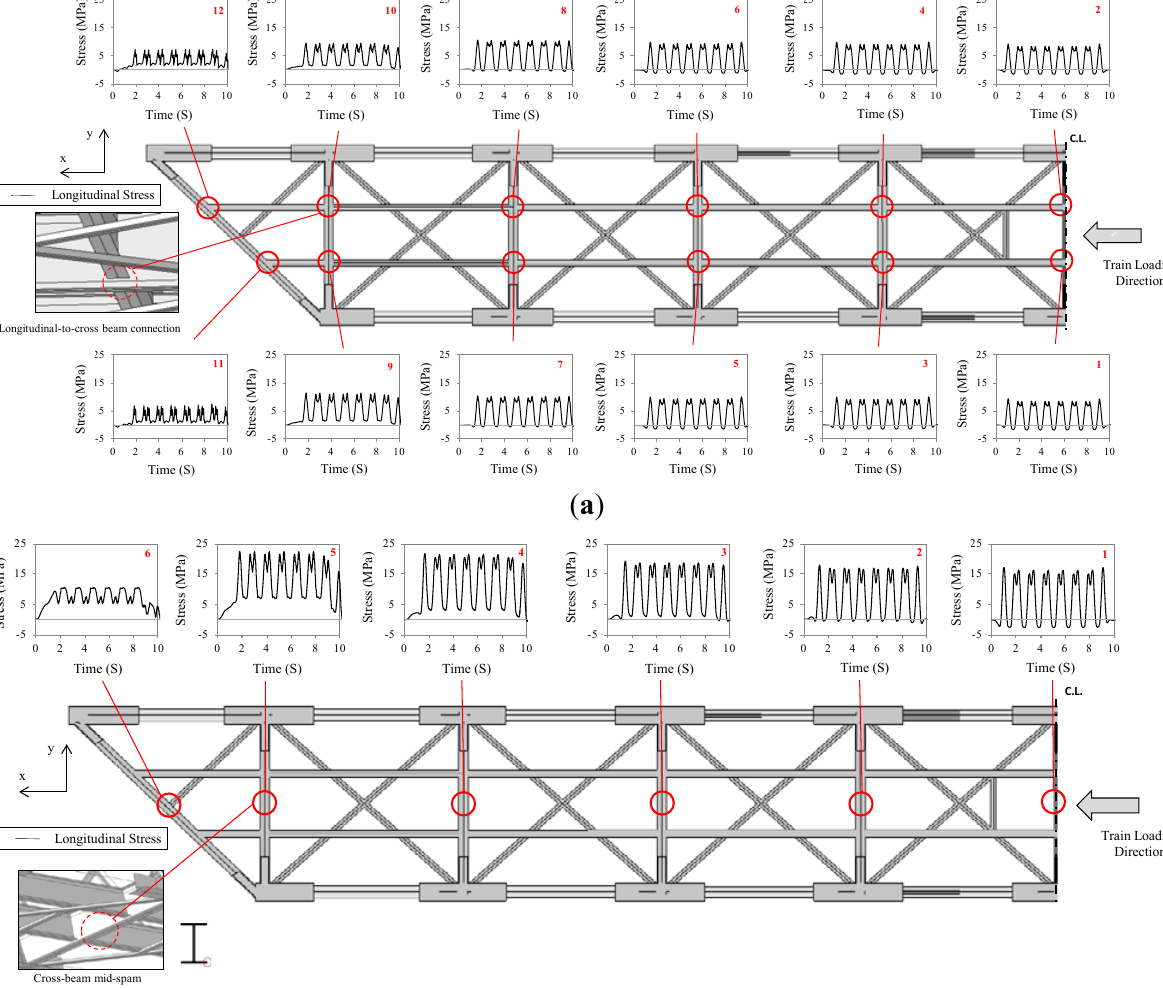
); and ( b ) Cross-beams at yy